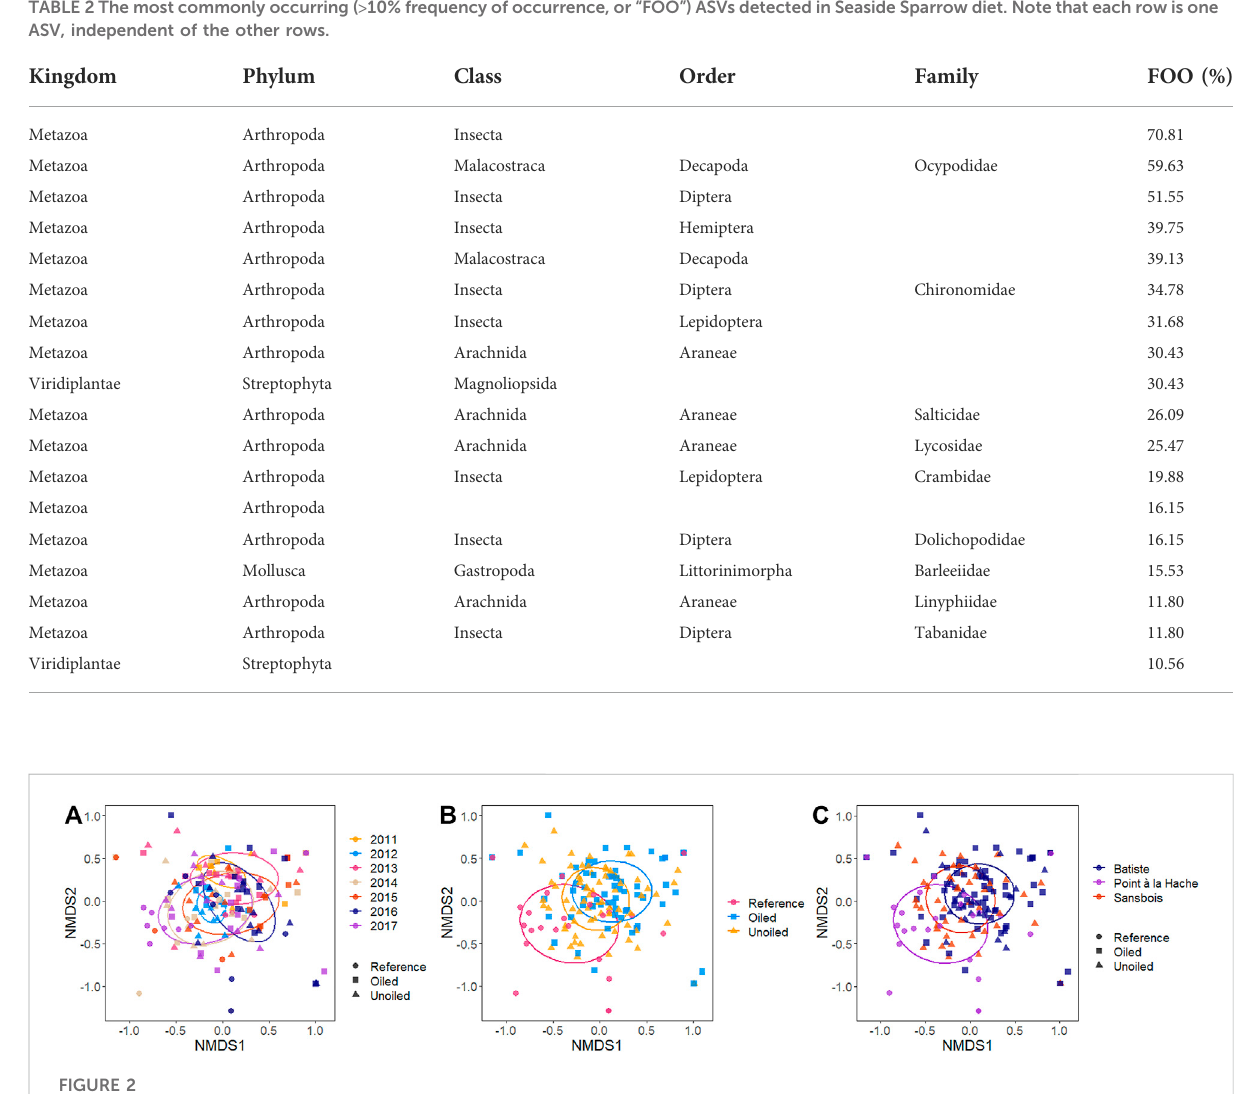
FIGURE 2 NMDS plot of all diet points coded to show the spread of diet between years (A) , site type (B) , and bay (C) . Samples that are more similar in composition are closer together. Three outlier points have been removed for the sake of visualization. Stress = 0.17. Ellipses show 95% con fi dence